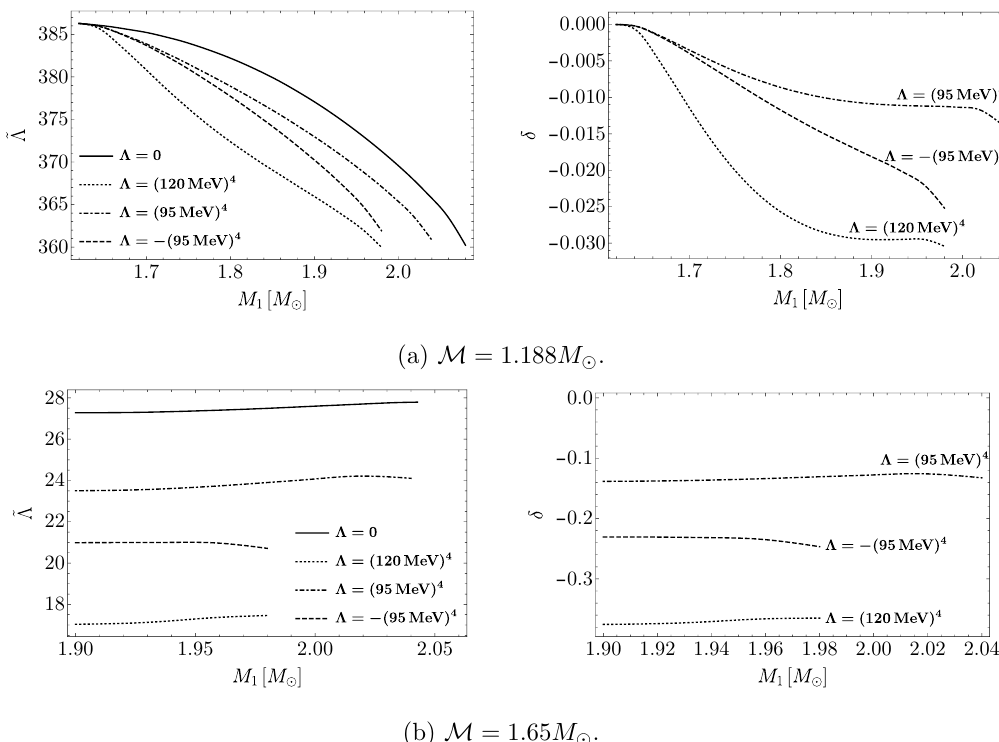
Figure 6. Plot of the deviation of the combined dimensionless tidal deformability as a function of the heavy star mass for the SLy EoS with di(cid:11)erent values for the chirp mass. M = 1 : 188 M (cid:12) is the same as the one of GW170817, while M = 1 : 65 M (cid:12) corresponds to a chirp mass where if the two NS masses are equal they have a mass of 1 : 9 M (cid:12) . For the smaller chirp mass the e(cid:11)ect is rather small, however for a higher chirp mass the e(cid:11)ect can be as large as 38%. The (cid:11) -parameter of (2.14) is again chosen to be (cid:11) =